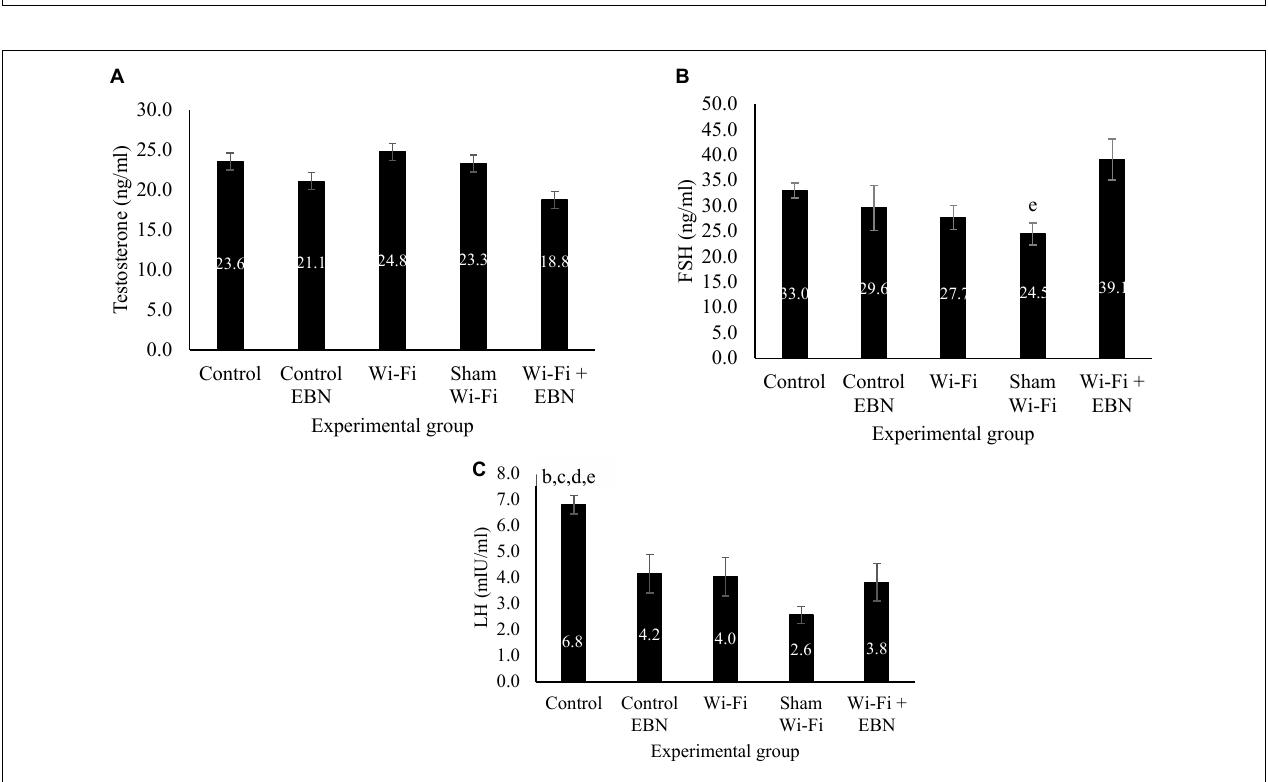
FIGURE 5 | Serum hormonal level of male reproductive hormones in each group following exposure. Data are presented as mean ± SEM ( n = 6). (A) Serum testosterone level in each group following the Wi-Fi exposure. No significant difference was noted among the groups. (B) Serum FSH level in each group following the Wi-Fi exposure. e Significant difference compared with Wi-Fi + EBN group. (C) Serum LH level in each group following the Wi-Fi exposure. b Significant difference compared with the Control EBN group ( p = 0.030), c Significant difference compared with the Wi-Fi group ( p = 0.039), d significant difference compared with the Sham Wi-Fi group ( p = 0.000), and e significant difference compared with the Wi-Fi + EBN group ( p = 0.011).